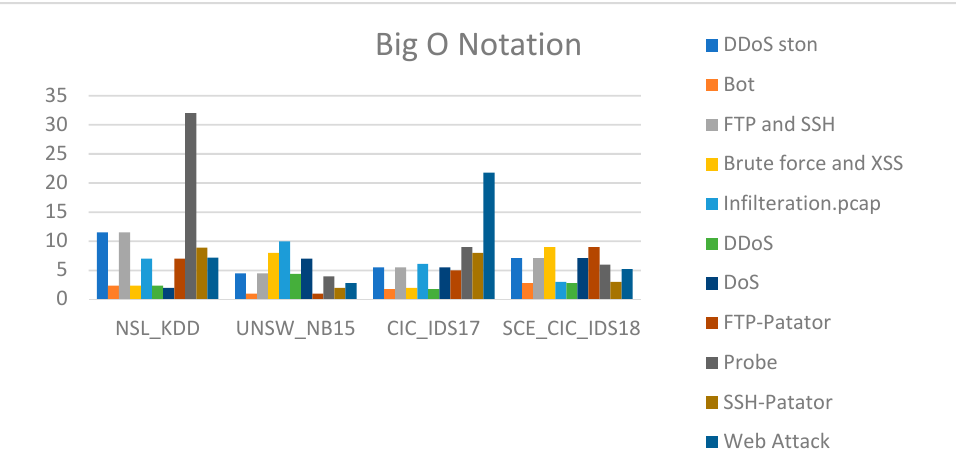
Figure 7. Final measurement matrix when applying meta-model system.